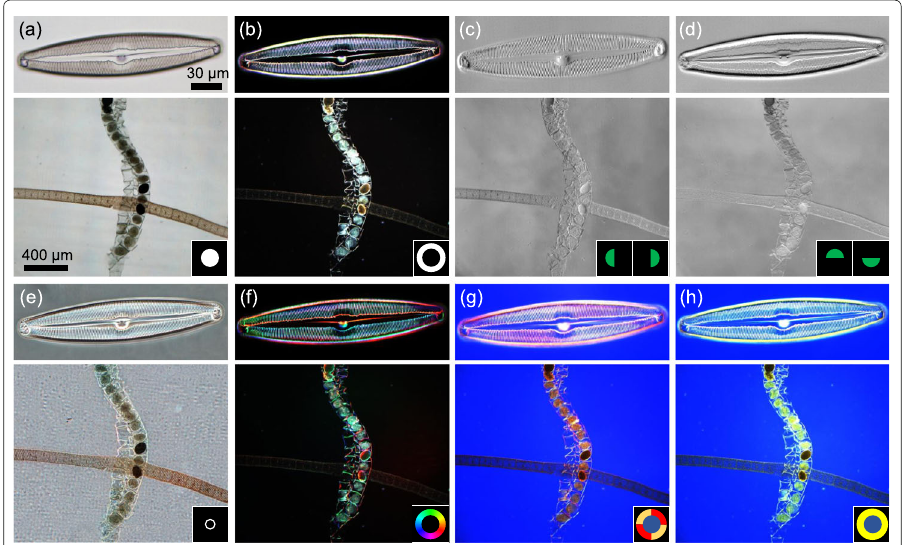
Fig. 13 Multi-contrast microscopic imaging results of a small single diatom microalgae cell and spiral algae with different objective lenses, including bright field, dark field, DPC, ZPC, Rheinberg optical staining. (a), (b) Observation results under bright field and dark field imaging. (c), (d) Observation results under DPC imaging along the left-right and up-down shearing directions. (e) Observation results under ZPC. (f)-(h)